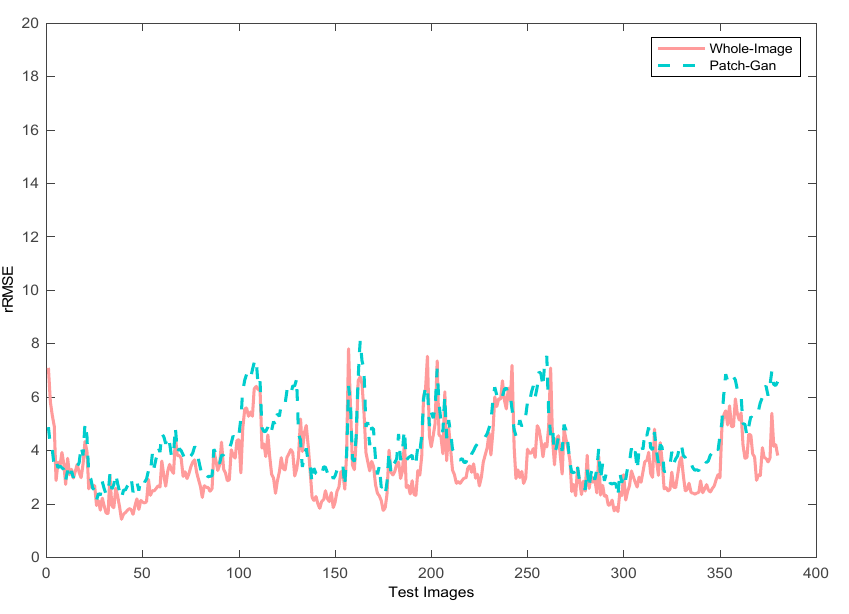
Figure 12. Comparison of reconstruction results using whole-image discriminator and patch-GAN on SD rat dataset.